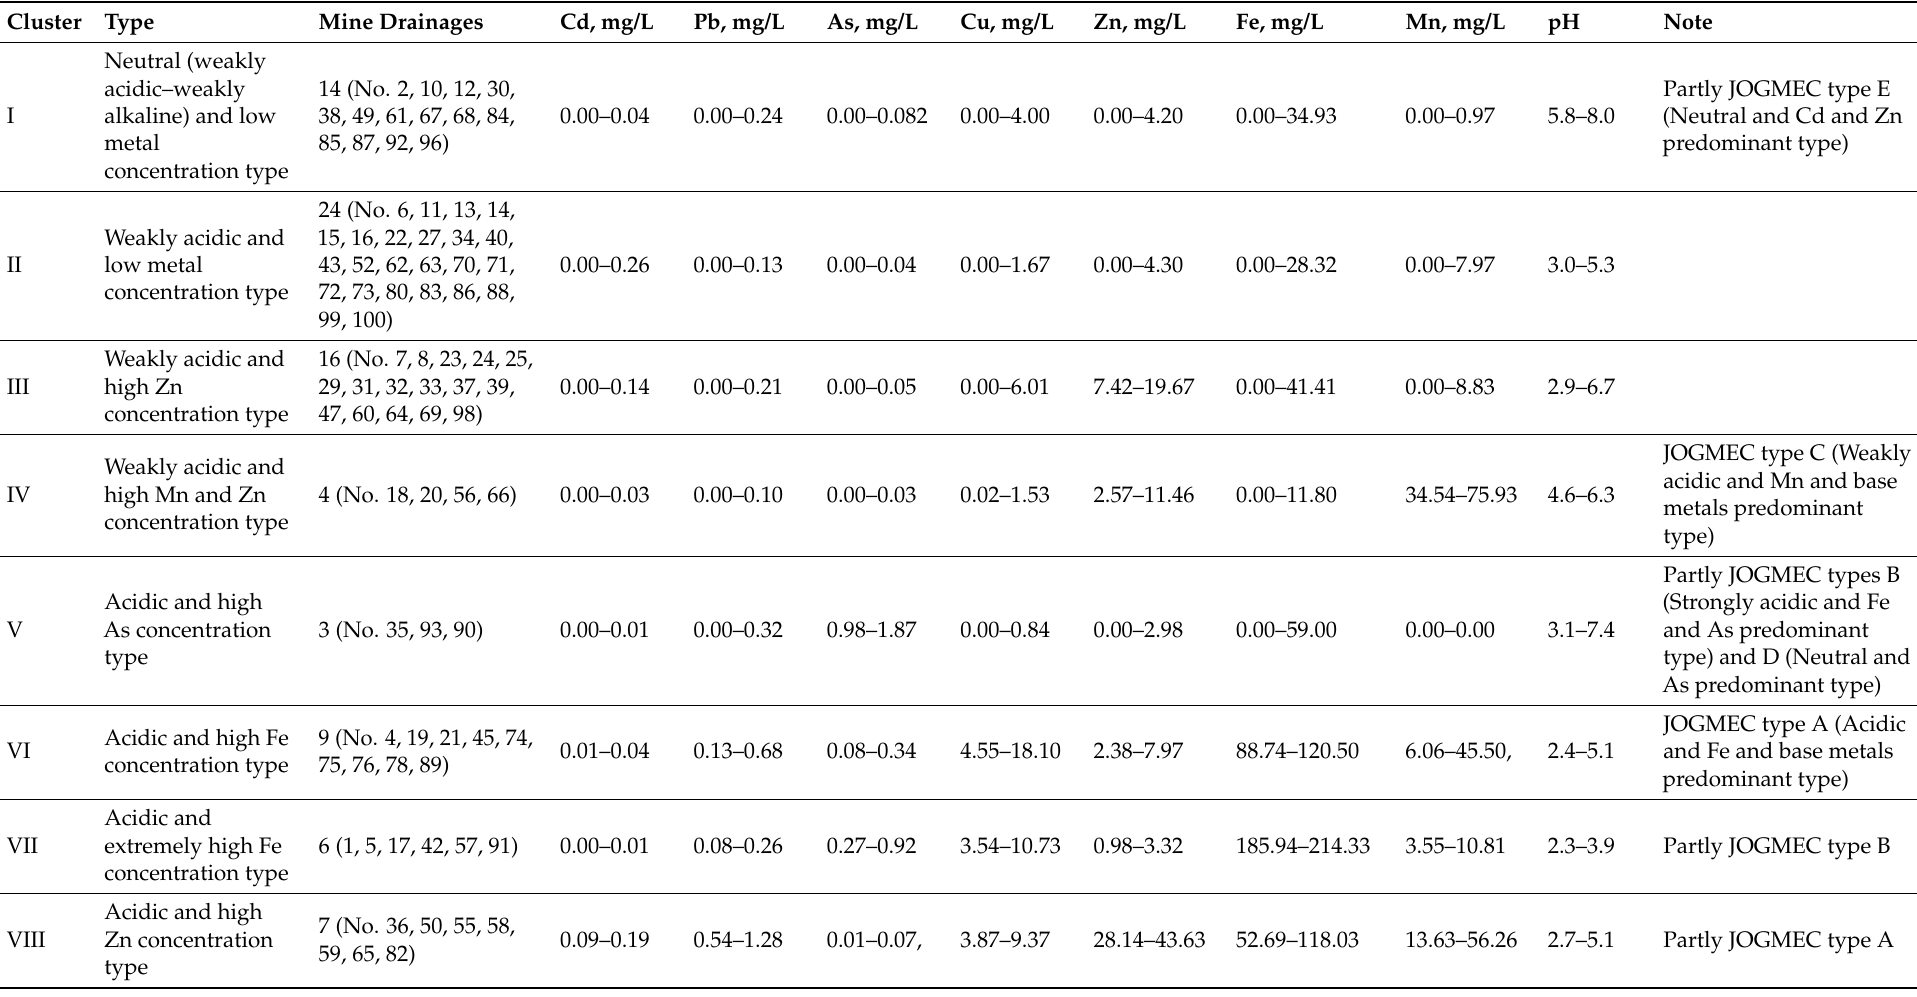
Table 1. Classification of mine drainages in Japan (2014–2016) based on the cluster analysis (Figures 3 and